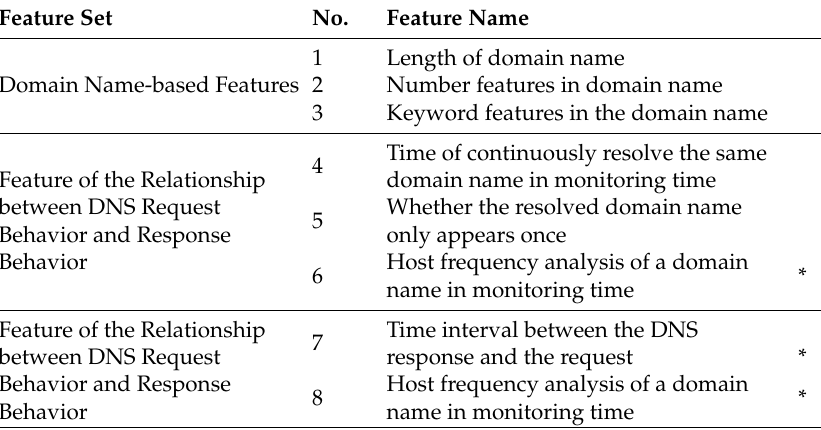
Table 1. Feature sets (* for new